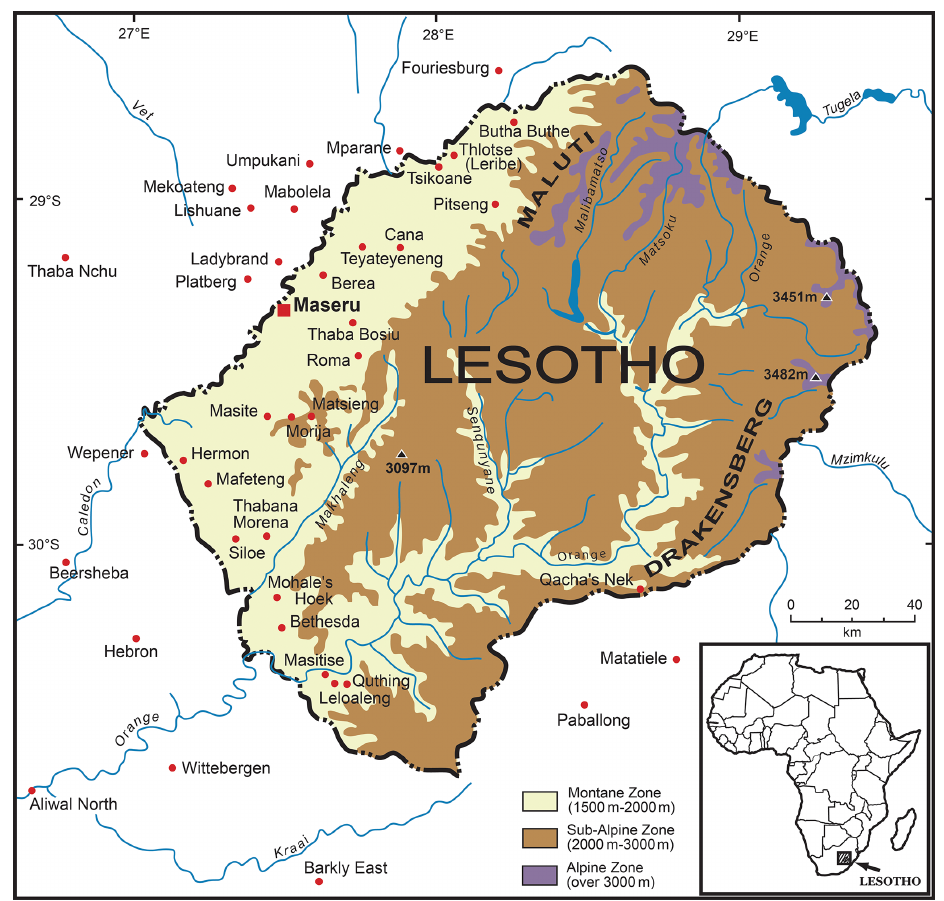
Figure 1. Map of locations within and adjacent to present-day Lesotho from which documentary evidence of rainfall variability was obtained by Nash and Grab